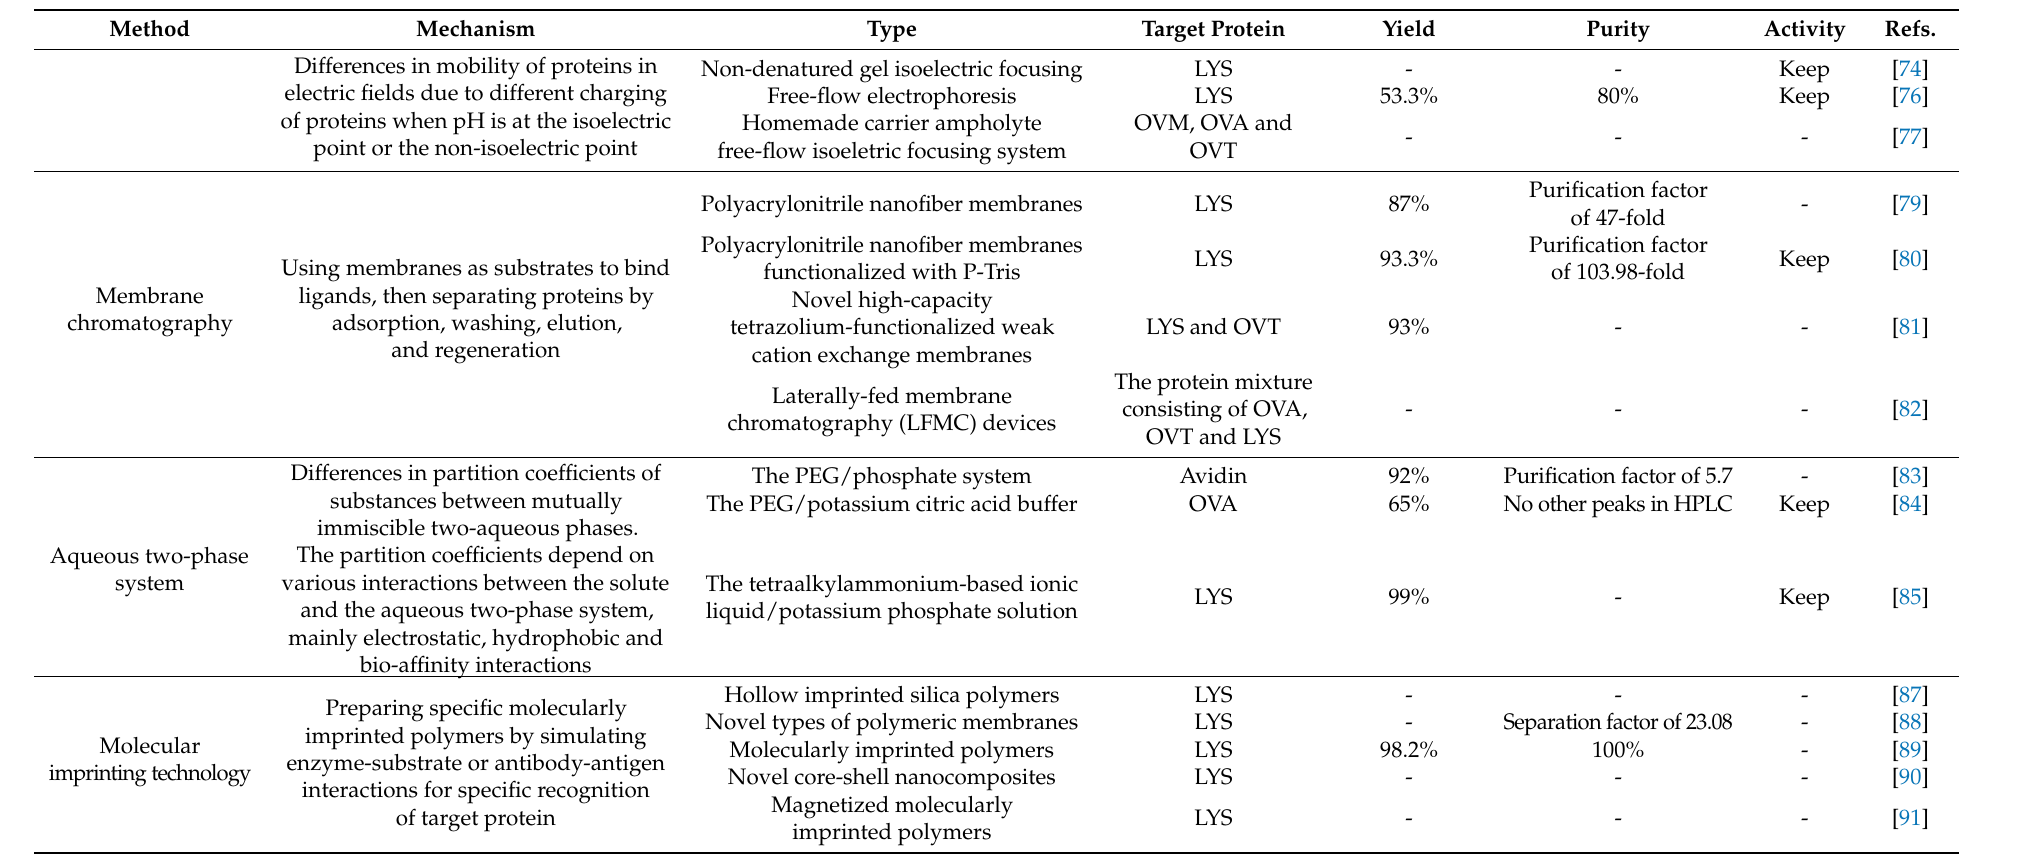
Table 3. Applications of novel